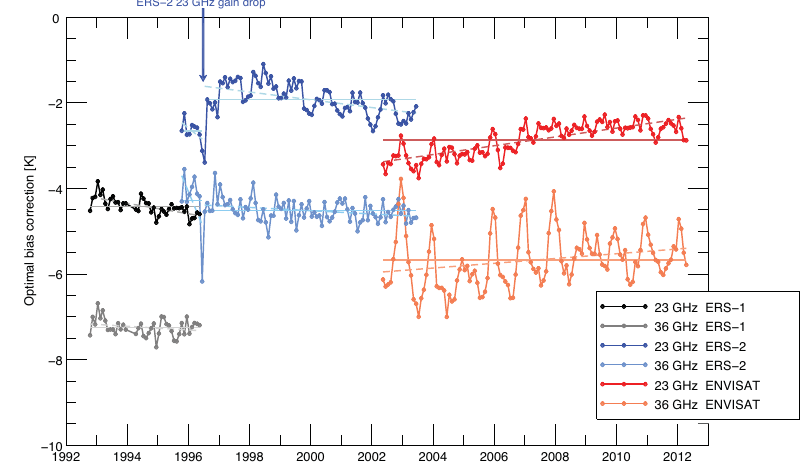
Figure 3. Optimal bias correction values for the entire time series shown as coloured lines with filled circles marking each monthly value. Also shown are the temporal mean values for each channel and instrument (straight lines in slightly lighter colours than the corresponding monthly values) and a regression line (dashed lines). For ERS-2 two separate fits were performed. One corresponding to the period before the 23GHz gain drop and another one for the period after the gain drop. The blue arrow highlights the time the day drop happened (26 June 1996). A negative bias correction value means that the observations are warmer than the simulations and thus need to be corrected downwards.